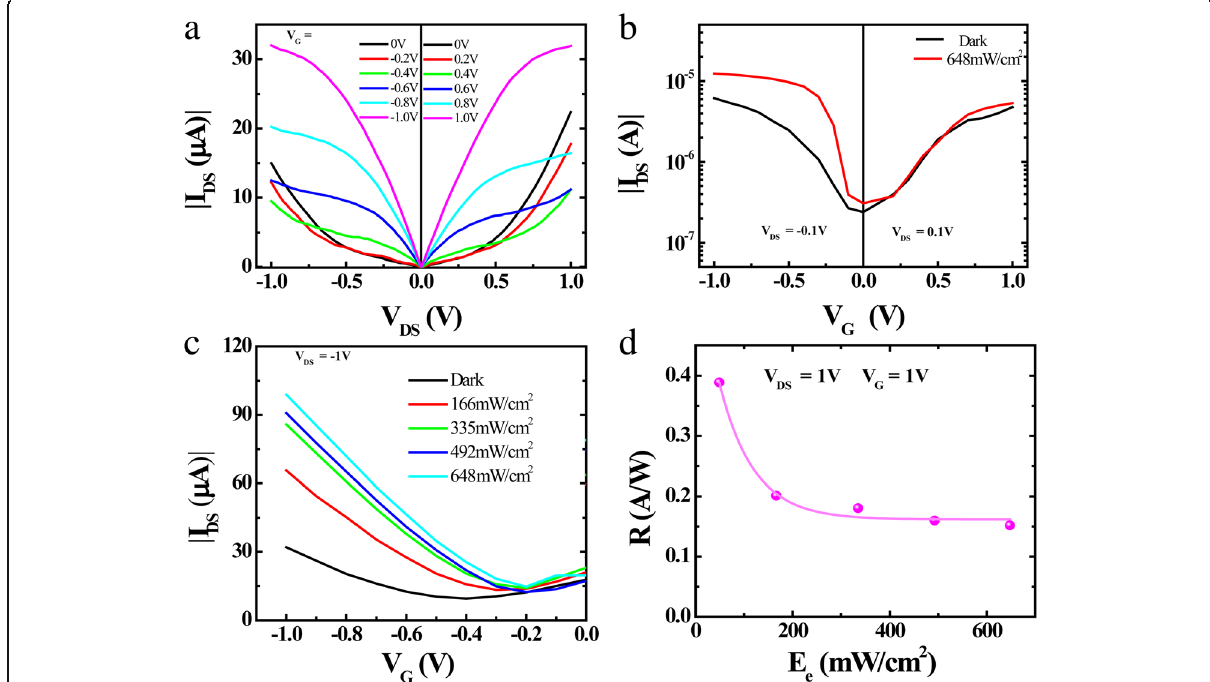
Fig. 2 Electrical properties of the perovskite photodetector. a Output characteristics at different V GS in the darkness. b Transfer characteristics ( I DS vs V GS ) at V DS = 0.1 V with illumination (red line) and in the darkness (black line). c Transfer curve of photodetector as a function of negative gate- source voltage at V DS = 1 with varying incidence optical powers. d Responsivity ( R ) with a relationship of excitation light ( E e